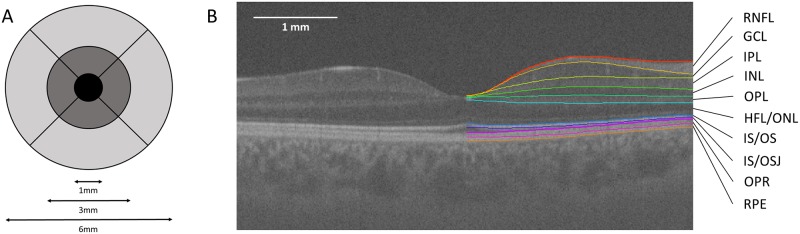
ETDRS grid and example 10 intra-retinal layer segmentation.(A) Standard ETDRS grid showing the foveal subfield (black). The inner ring is an average of the four parafoveal subfields (dark grey) and the outer ring of the four perifoveal subfields (light grey). (B) Screenshot of 10 layer (11 boundary) segmentation of a long-wavelength OCT image, produced by the Iowa Reference Algorithms. The left half of the image shows the image prior to segmentation. Layers 1–10 (top to bottom; as defined by the software): retinal nerve fiber layer (RNFL); ganglion cell layer (GCL); inner plexiform layer (IPL); inner nuclear layer (INL); outer plexiform layer (OPL); outer plexiform layer-Henle fiber layer to boundary of myoid and ellipsoid of inner segments (OPL-HFL ~ BMEIS); photoreceptor inner/outer segments (IS/OS); inner/outer segment junction to inner boundary of outer segment photoreceptor/retinal pigment epithelium complex (IS/OSJ ~ IB_RPE); outer segment photoreceptor/retinal pigment epithelium complex (OPR); retinal pigment epithelium (RPE).